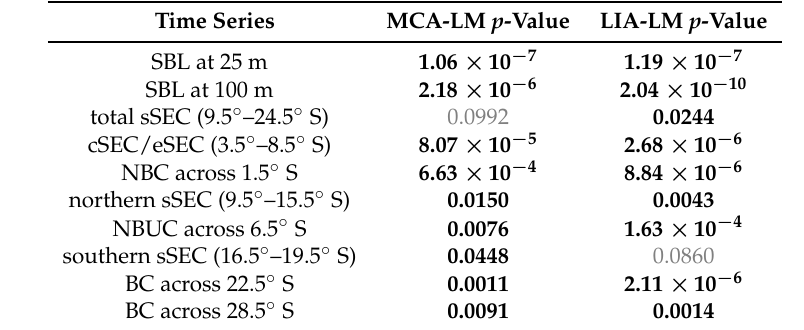
Two-sided t -test values ( p < 0.05) between the MCA/LIA and the LM intervals. The significance test was performed between time series of the monthly anomalies, with no low-pass filtering. p -values smaller than the 0.05 significance level (i.e., H = 1) are marked in bold, while p -values greater than 0.05 (i.e., H = 0) appear in